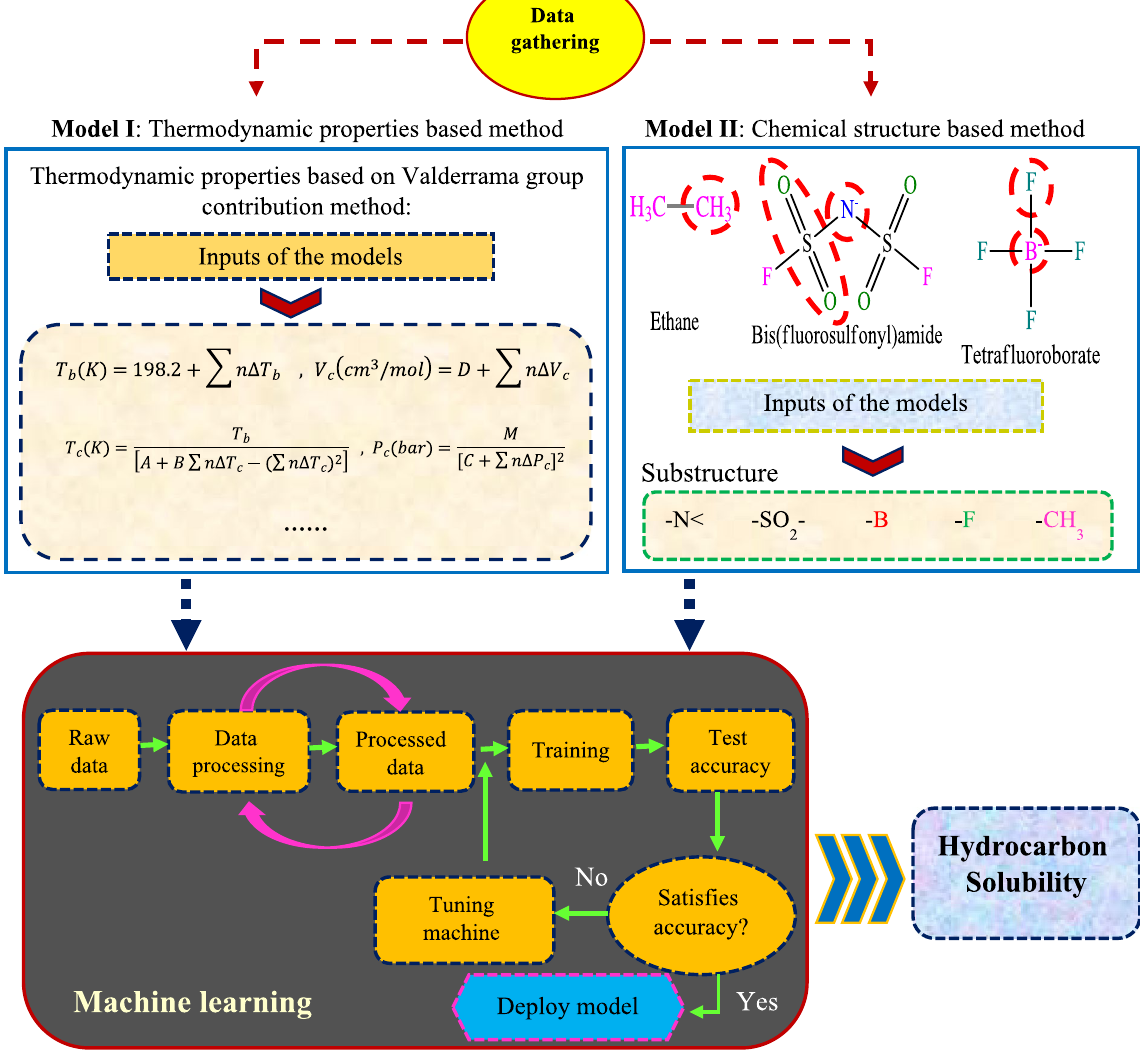
Figure 7. Procedure of data preparation and model development for hydrocarbon solubility